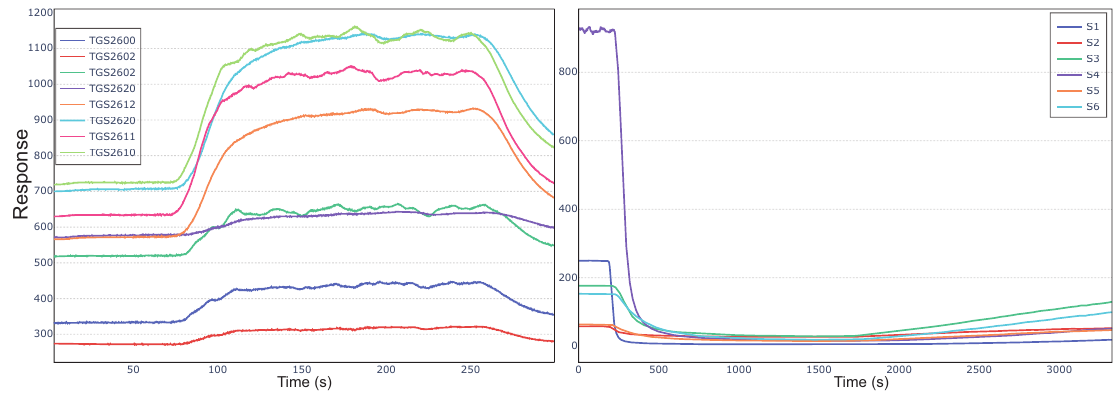
Figure 1. Typical sensor response curves in two datasets. Left : dataset2; Right :